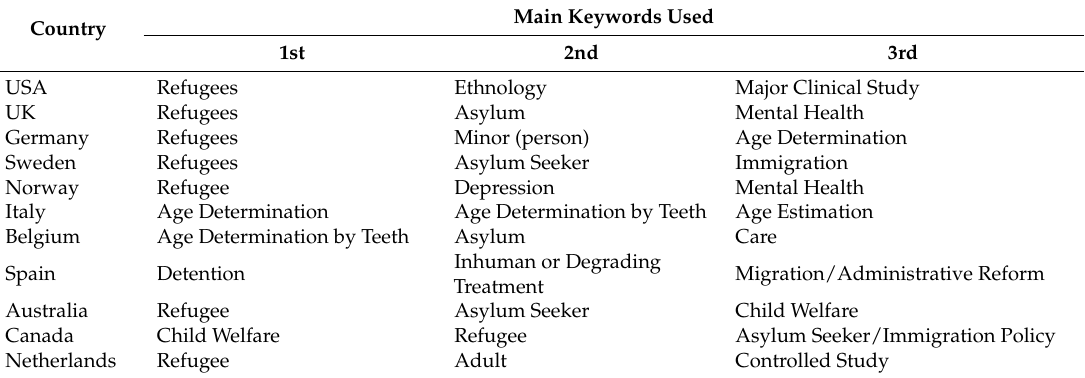
Table 2. Main keywords of the countries with the greatest scientific interest in unaccompanied minors. Country